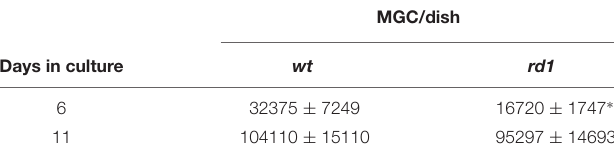
TABLE 1 | Number of MGC per